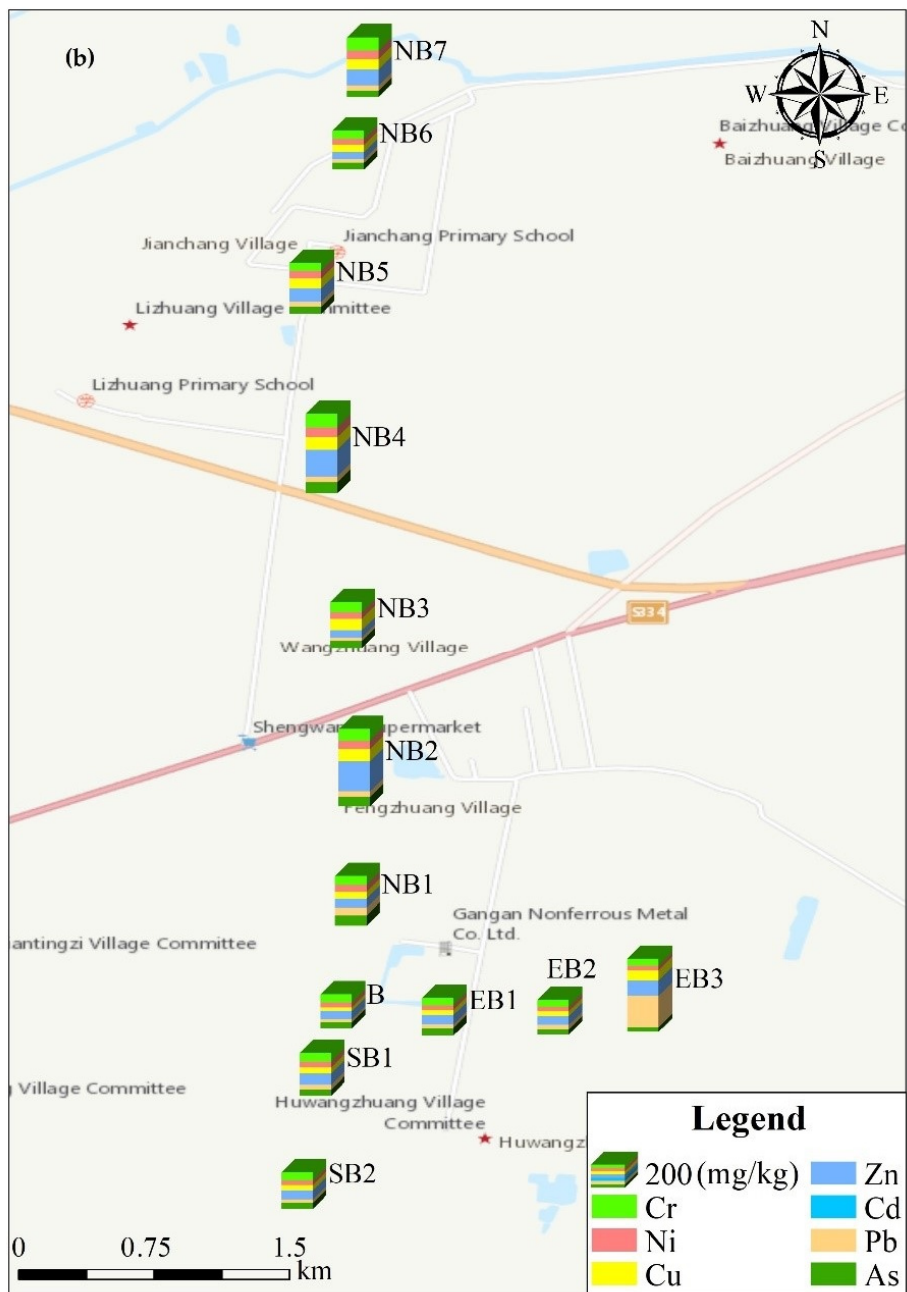
Figure 3. Spatial distribution of heavy metals in soil surrounding Smeltery A and B. ( a ) Smeltery A; ( b ) Smeltery A and B.